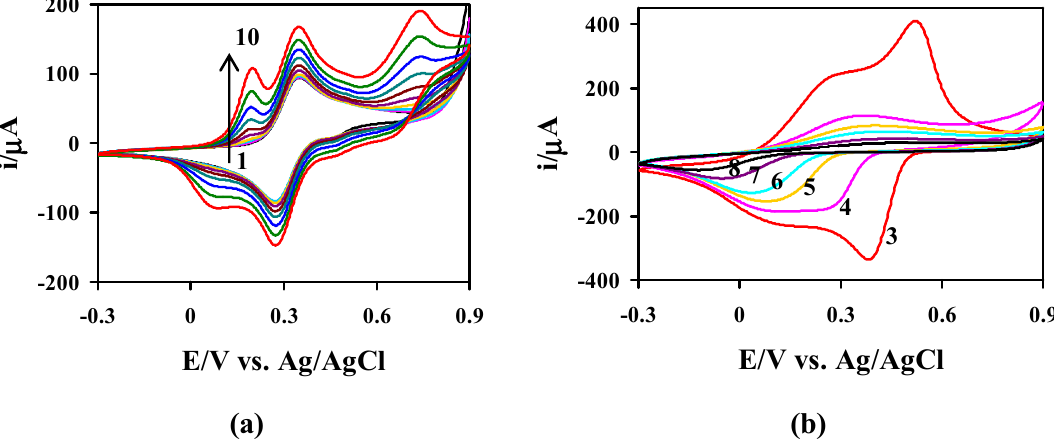
Figure 1. (a) The film growth of the poly(Ani- co - m -FcAni) during electrolysis of 0.1 M Ani, and 0.005 M m -FcAni in 0.5 M H SO containing 30% ACN: (1) 1st cycle and 2 4 (10) 10th cycle at the scan rate of 50 mV s − 1 . (b) The CVs of the poly(Ani- co - m -FcAni) modified electrode at different pH at 3, 4, 5, 6, 7 and 8 at a scan rate of 50 mV s − 1